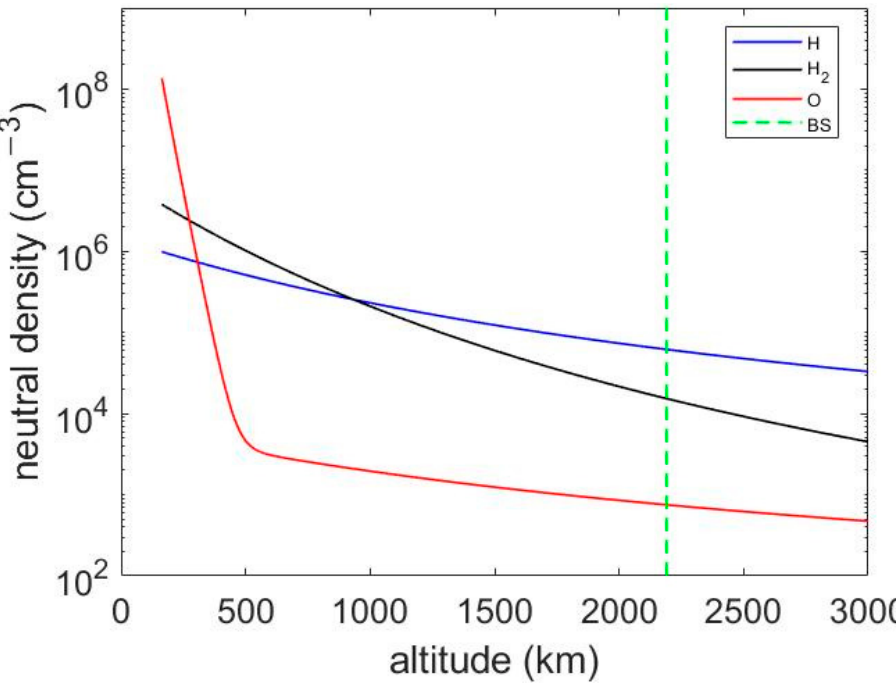
Figure 2. Neutral density profiles of the exosphere model. Dashed line represents the position of the bow shock at the subsolar point.